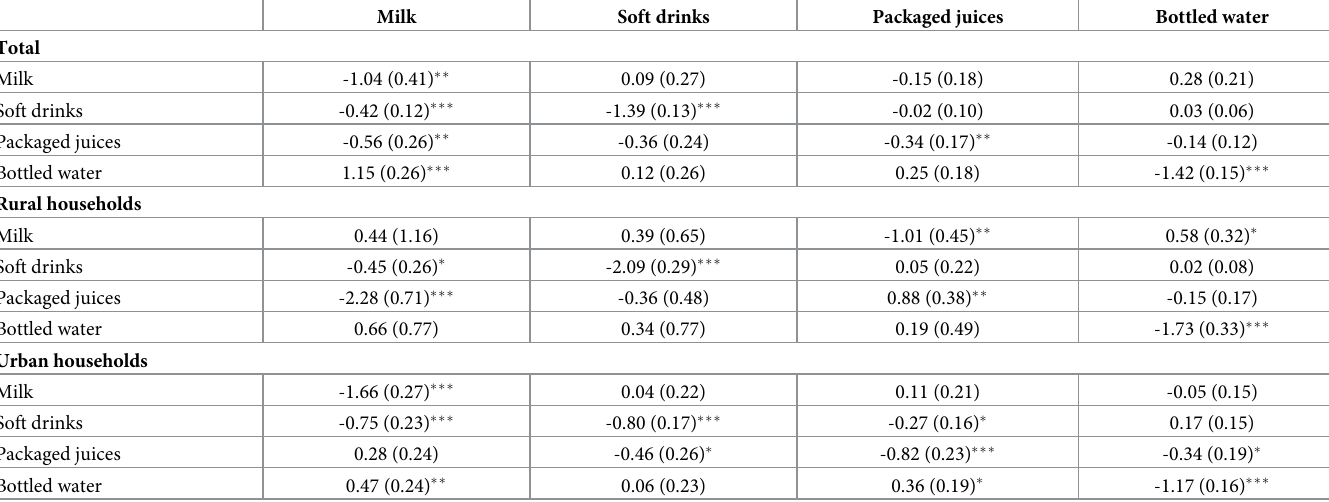
Table 3. Matrix of own- and cross-price beverage price elasticity estimations and standard errors (SE) 1 using Deaton’s AIDS by area.